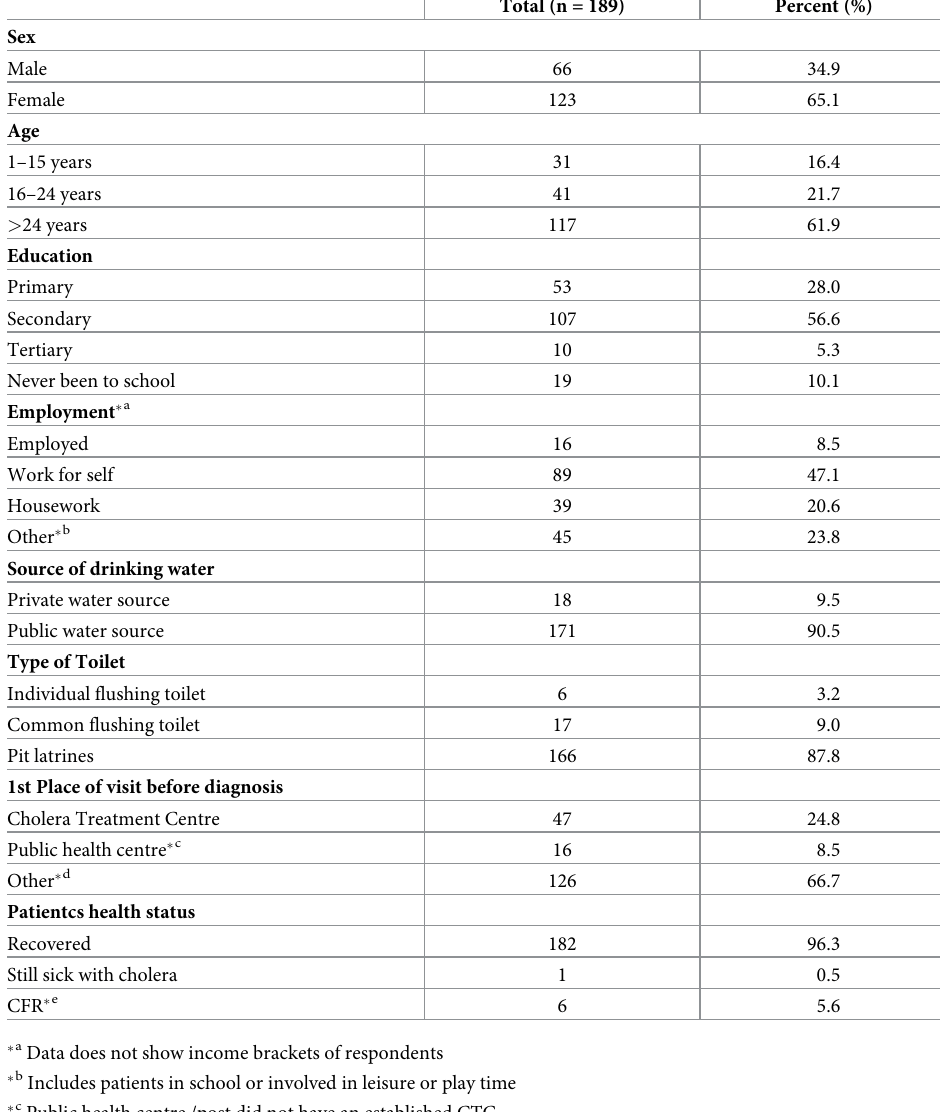
Table 3. Selected characteristics of study participants and